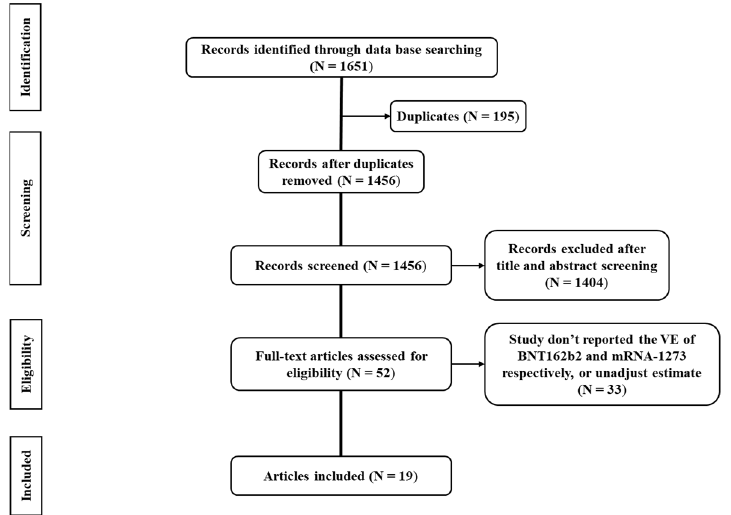
Figure 1. Preferred Reporting Items for Systematic Reviews and Meta-analyses (PRISMA) flow diagram of the process of study selection.